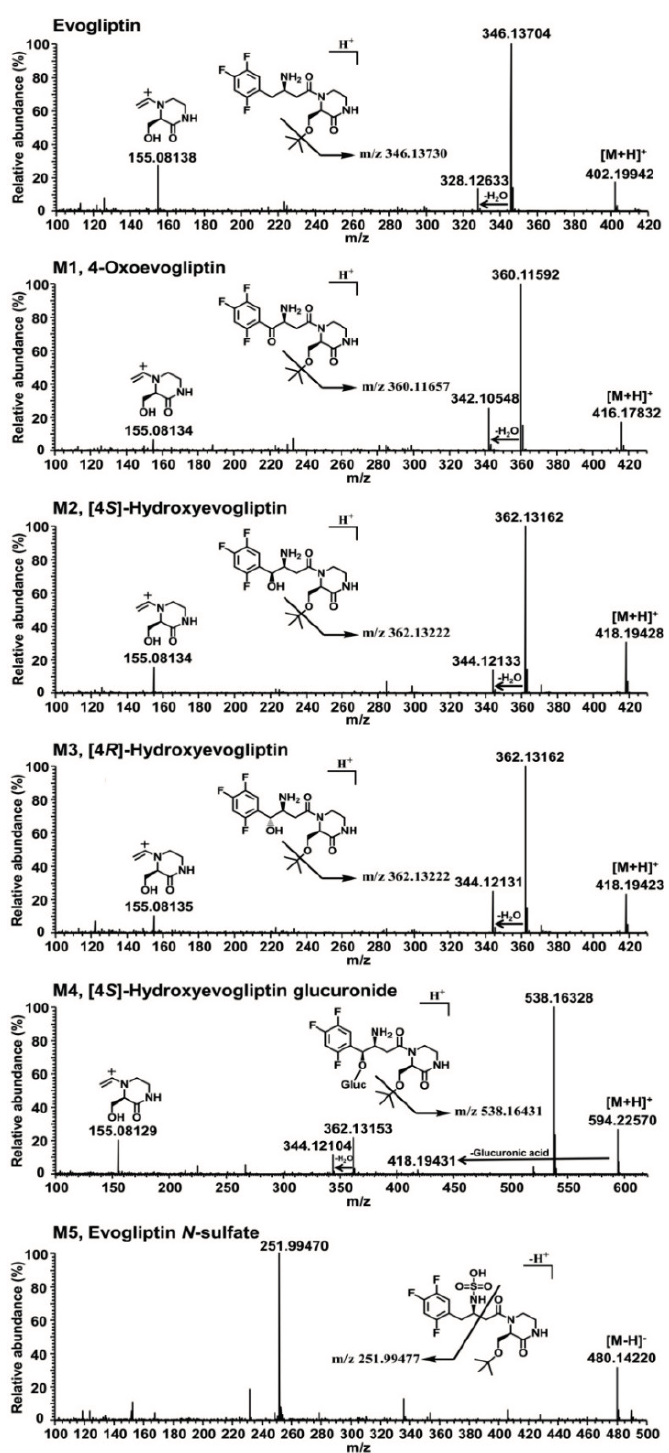
Figure 2. Product scan spectra of evogliptin and the five metabolites M1, M2, M3, M4, and M5 formed after incubation of evogliptin with human